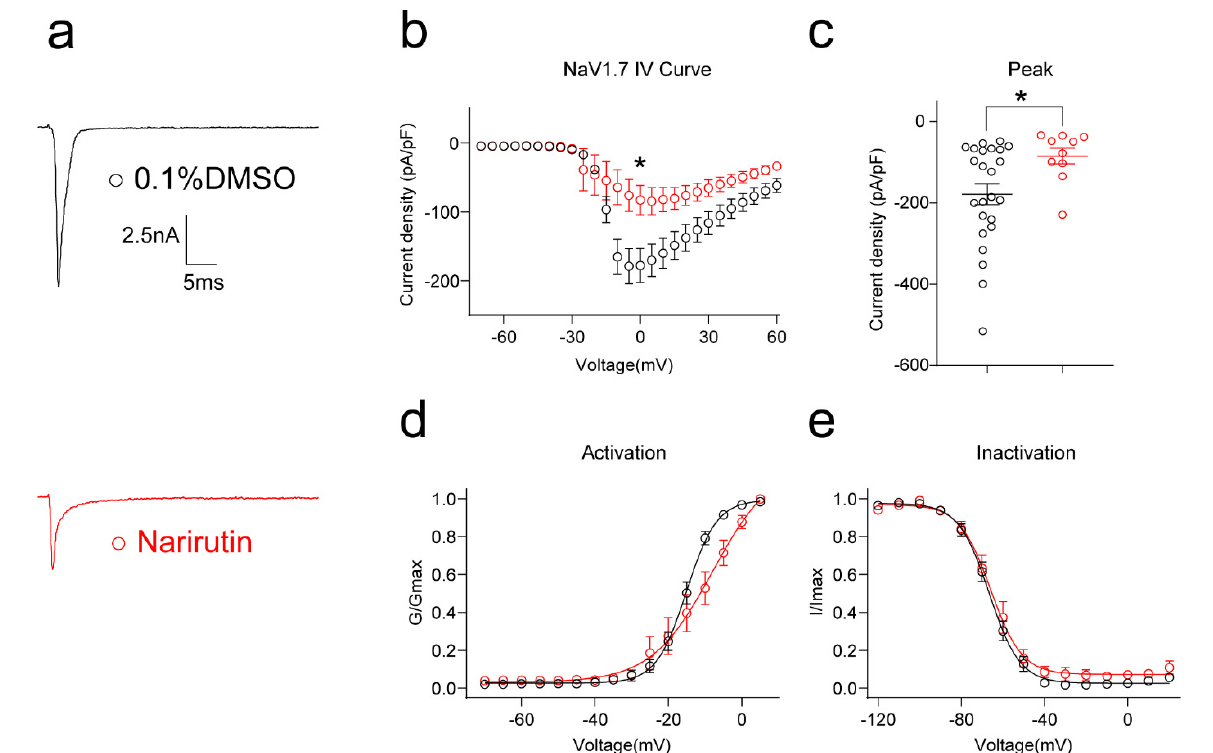
Figure 7. Narirutin reduces the Na v 1.7 currents in the HEK293 cell line. ( a ) Representative traces of the Na v 1.7 currents from HEK293 cells transfected using pcDNA3.1- Na v 1.7-Flag with GFP plasmid and incubated overnight with 0.1% DMSO or Narirutin 20 µ M. Currents were evoked by 200 ms pulse between − 70 and +60 mV. Summary of ( b ) the normalized (pA/pF) sodium current density versus voltage relationship and ( c ) peak Na v 1.7 current density at − 10 mV from HEK293 cells treated as indicated. Boltzmann fits for normalized conductance, G/Gmax voltage relationships for voltage- dependent ( d ) activation, and ( e ) inactivation sensory neurons. The half-maximal activation (V 1/2 ) and slope values ( k ) for activation and inactivation are summarized in Table 1. Data are expressed as means ± SEM. Asterisks indicate statistical significance compared with vehicle treatment (* p < 0.05, Mann–Whitney test, n > 9 cells per condition).